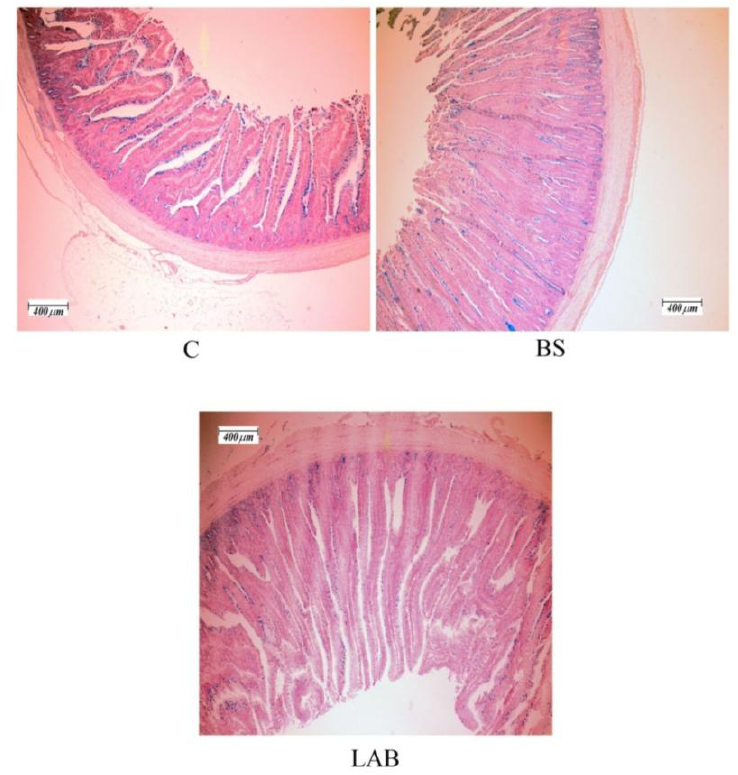
Figure 1. Photomicrograph of broiler jejunum stained with Alcian blue. Magnification  40. C = Control group (no addition probiotic); BS = Birds supplemented with Bacillus subtilis based probiotic; LAB = Birds supplemented with lactic acid bacteria based